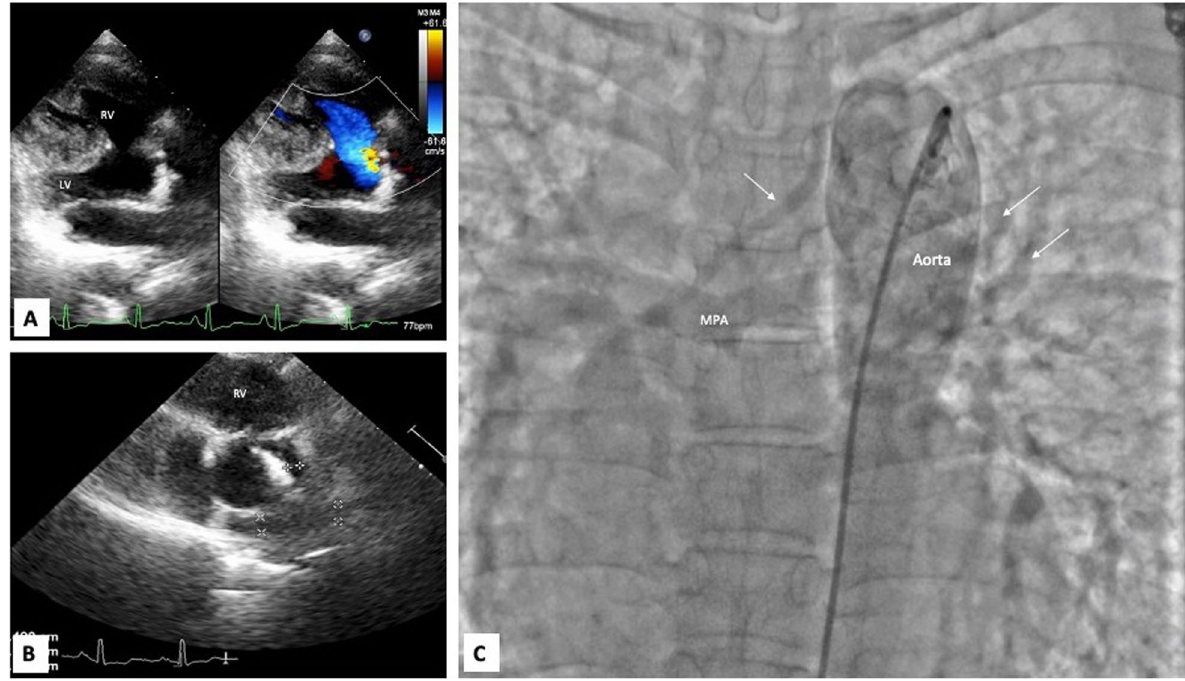
Fig. 2 A Parasternal long axis view of echocardiography showing large ventricular septal defect with right to left shunt, right ventricular hypertrophy and malaligned aorta. B Parasternal short axis view of echocardiography at the level of aortic valve showing pulmonary valve atresia and confluent small pulmonary arteries. C Invasive angiogram with pigtail catheter in descending thoracic aorta showing major aortopulmonary collaterals (white arrows) filling the confluent pulmonary